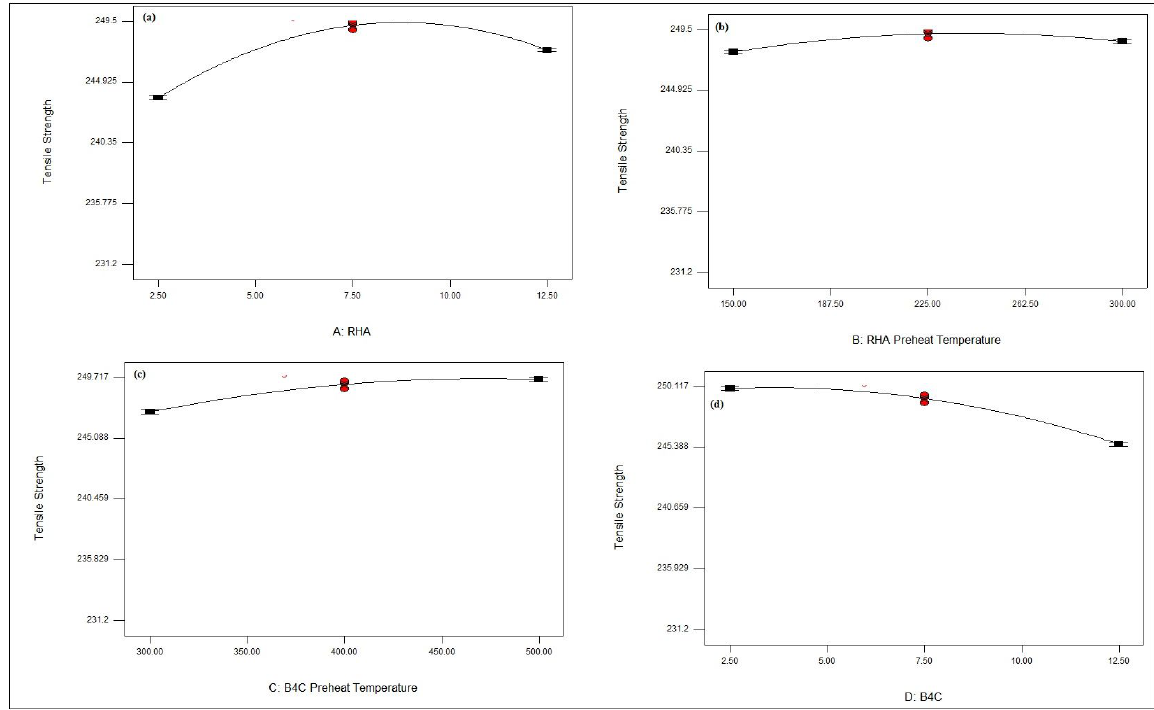
Figure 7: Single reinforcement parameters effect on tensile